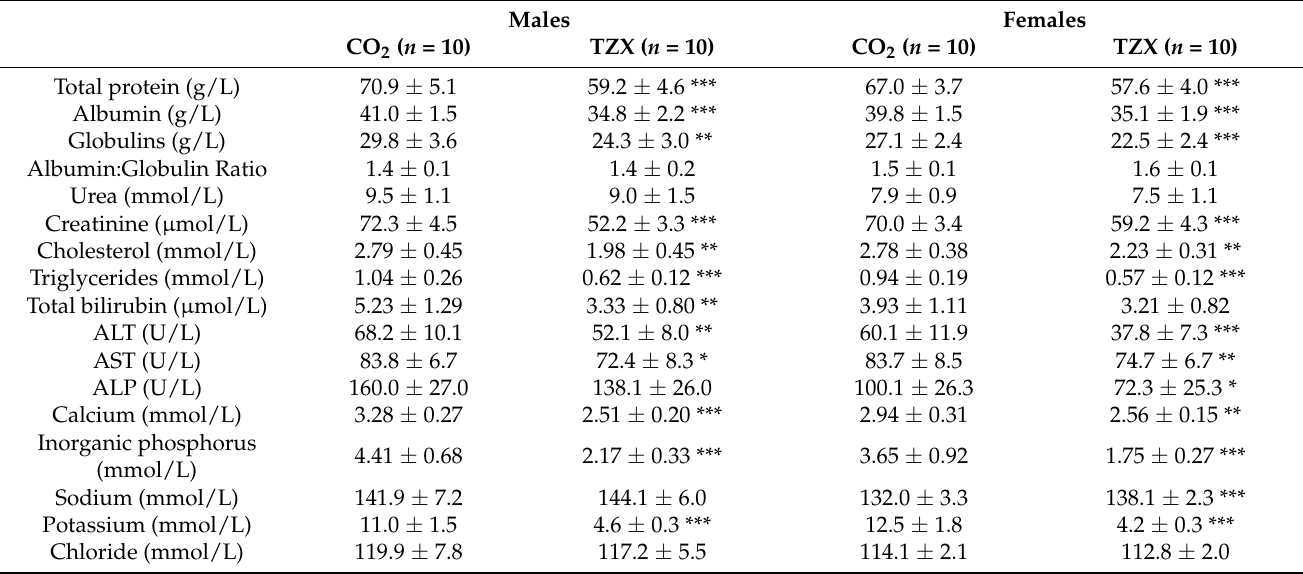
Table 2. Clinical biochemistry results for serum of Sprague Dawley rats collected in 5 min after CO 2 inhalation or tiletamine–zolazepam–xylazine